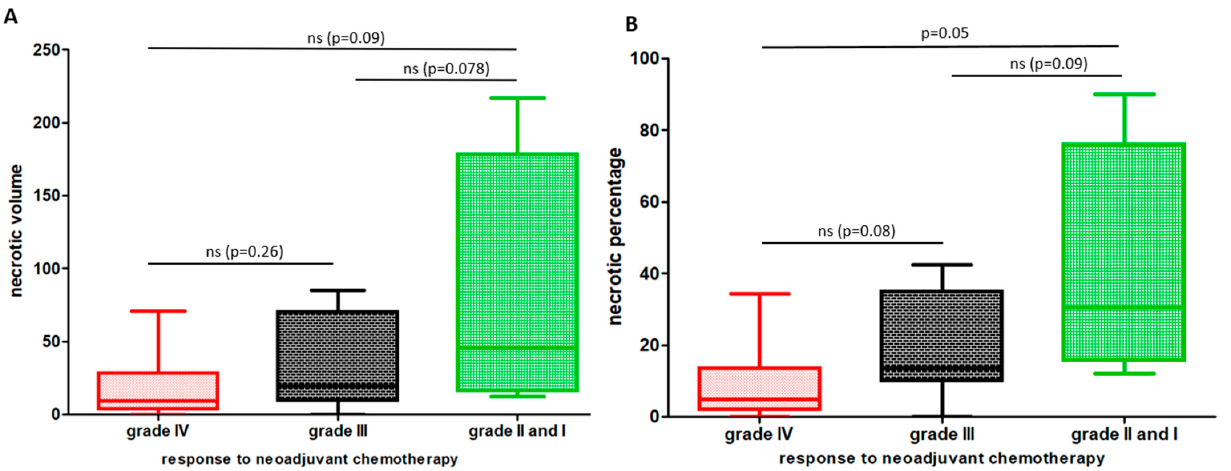
Figure 4. Correlations between radiological measures (NV, necrotic volume, (bar graph ( A )) and NP, necrotic percentage (bar graph ( B )) and Huvos grading observed on primary tumor resections. Grade IV group is represented in a red color, grade III group in black and the poor responders (grade II and I) in green. A global significancy was evidenced between these 3 groups when consid- ering NP ( p = 0.052) and only a minimal trend considering NV ( p = 0.08). The statistical group-by- group analysis on the graphs ( A,B ) is reported above each bar plot and finds only a significant dif- ference ( p = 0.05) between grade IV and grade II/I Huvos groups on NP parameter. p values are reported on the graphs. (ns = non-significant result).